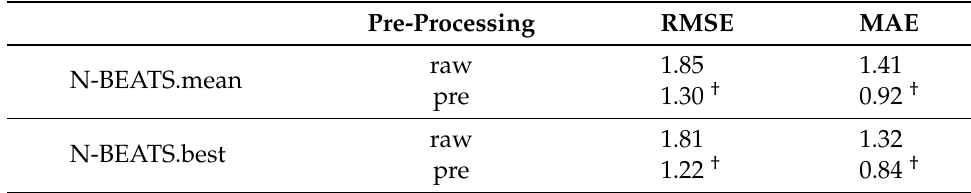
Table 6. Results with pre-processing of meals (pre) vs. original raw data for meal events (raw), for the Bolus ( ± c ) recommendation scenario on unrestricted examples. All meals (shifted or added) are used for the pre-processed data. The symbol † indicates a p -value < 0.01 when using a one-tailed t -test to compare against the results without pre-processing